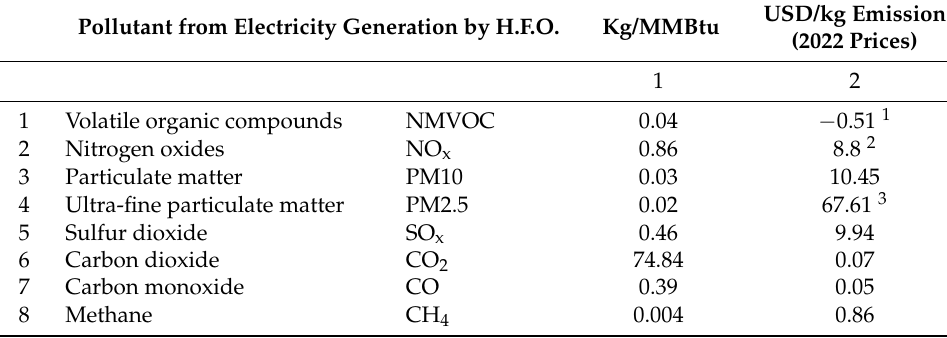
Table 4. Environmental Emission and Economic Cost of Pollutants of Diesel Fuel Generators. Pollutant from Electricity Generation by H.F.O.